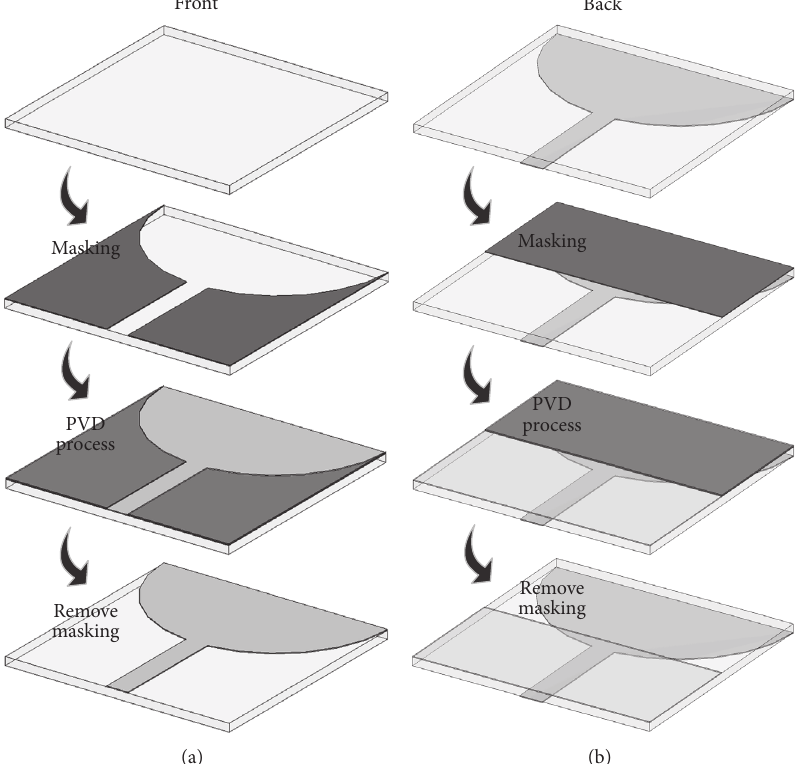
Figure 3: The fabrication process of the transparent UWB antenna. (a) Front. (b)